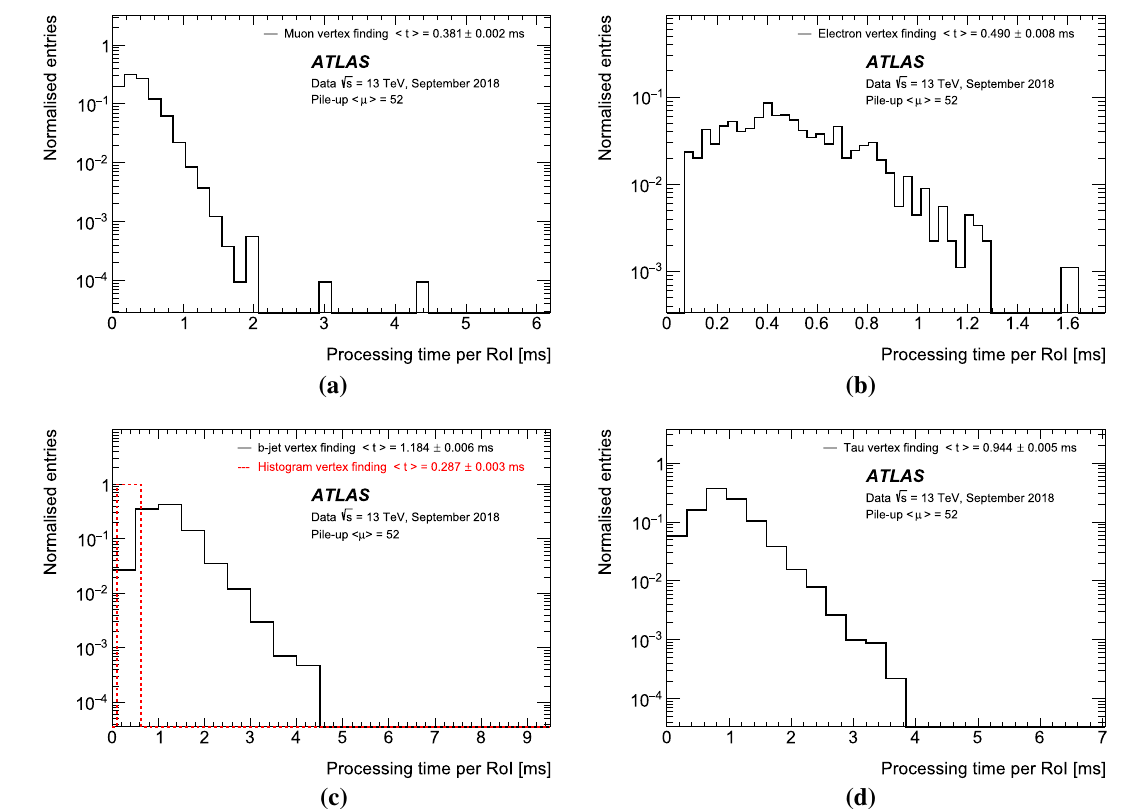
Fig. 15 The processing times for trigger vertex algorithms; a , b for the muon and electron signatures, c for the b -jet vertex tracking, and d for the tau